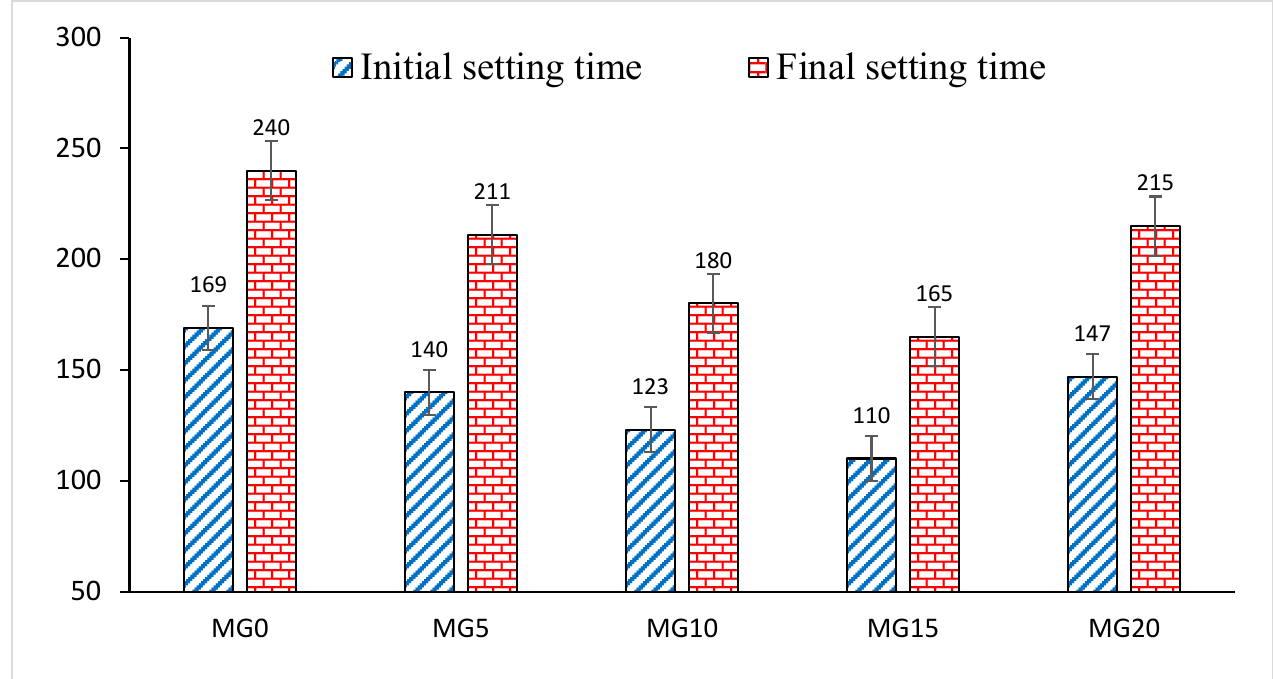
Figure 4. Effect of glass on the setting time of mortar.